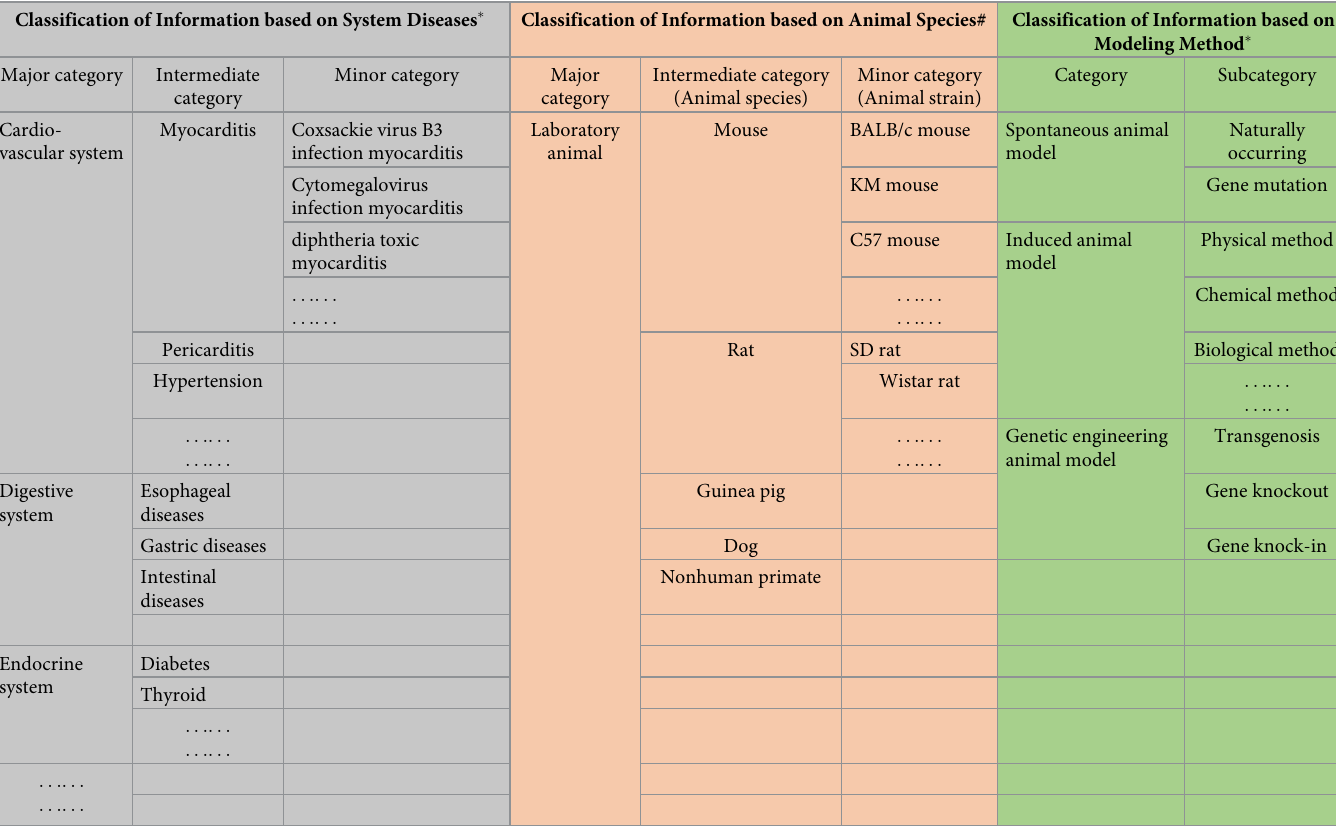
Table 1. Classification of animal models based on 3